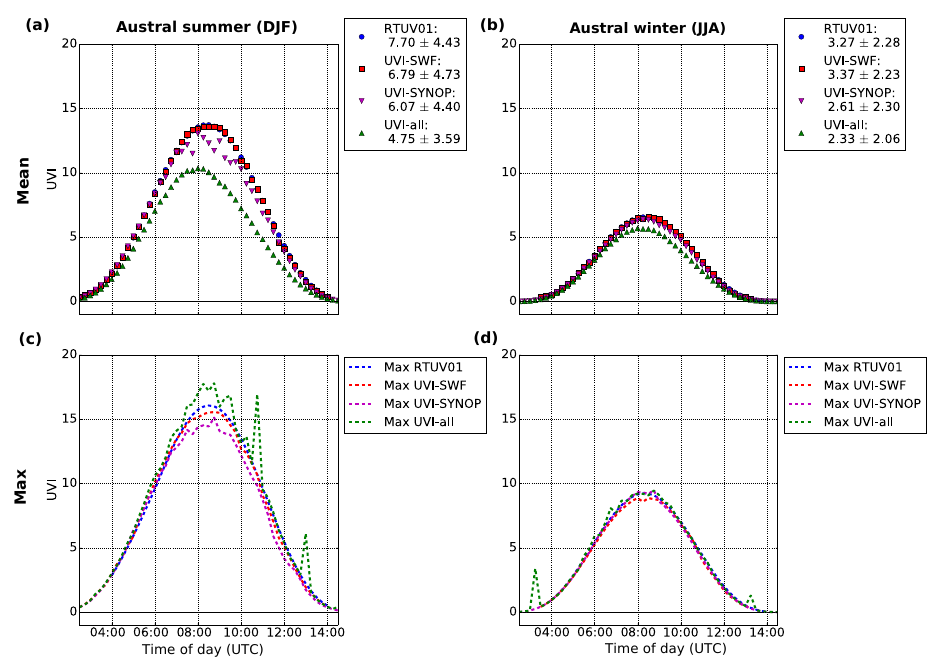
Figure 11. UVI diurnal cycle, seasonal climatology. Mean diurnal UVI on the top row and maximum diurnal UVI on the bottom row. Austral summer on the left side and austral winter on the right. RTUV01 in blue, UVI-SWF in red, UVI-SYNOP in purple and UVI-ALL in